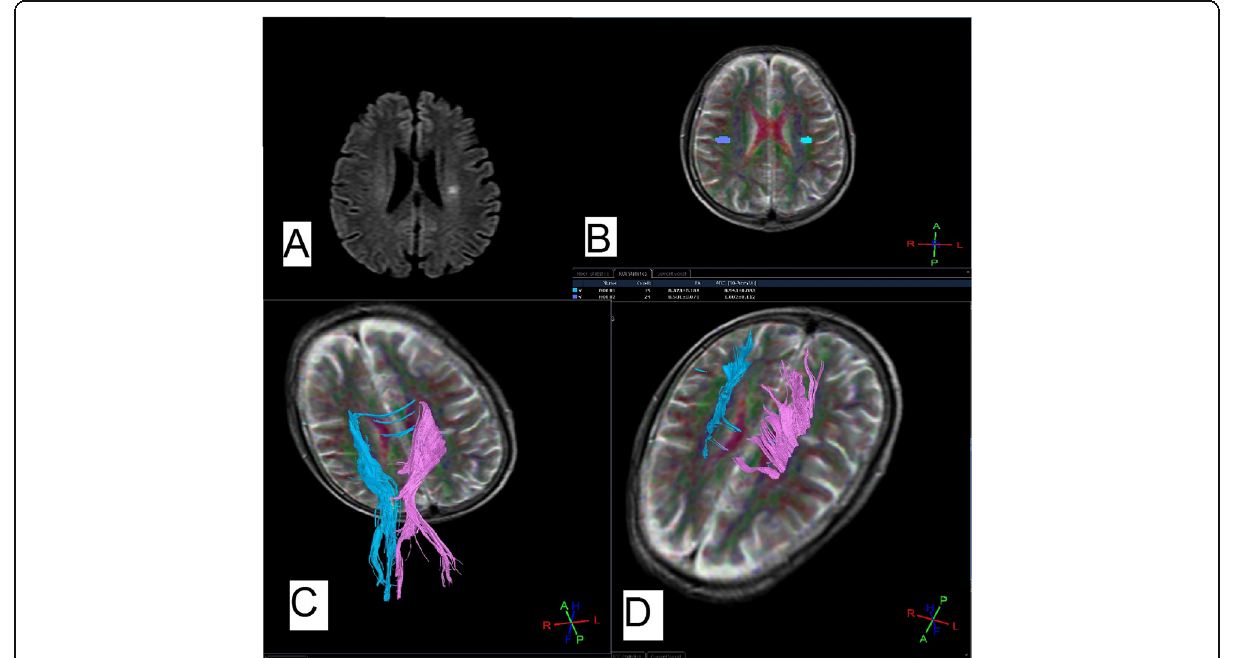
Fig. 4 A 64-year-old male patient, diabetic and hypertensive, presented with mild right-sided weakness. NIHSS on admission was 5 a axial diffusion WIs (b1000) show small left parietal acute infarct. b Axial color-coded FA map overlaid on axial T2 images showing reduced FA value at the site of infarct (0.3) compared to the contralateral normal side (0.5) c , d axial FA color-coded map overlaid over axial T2 image with 3D fiber tractography of the CST that appear preserved. The patient shows a significant clinical improvement with residual speech difficulties. NIHSS